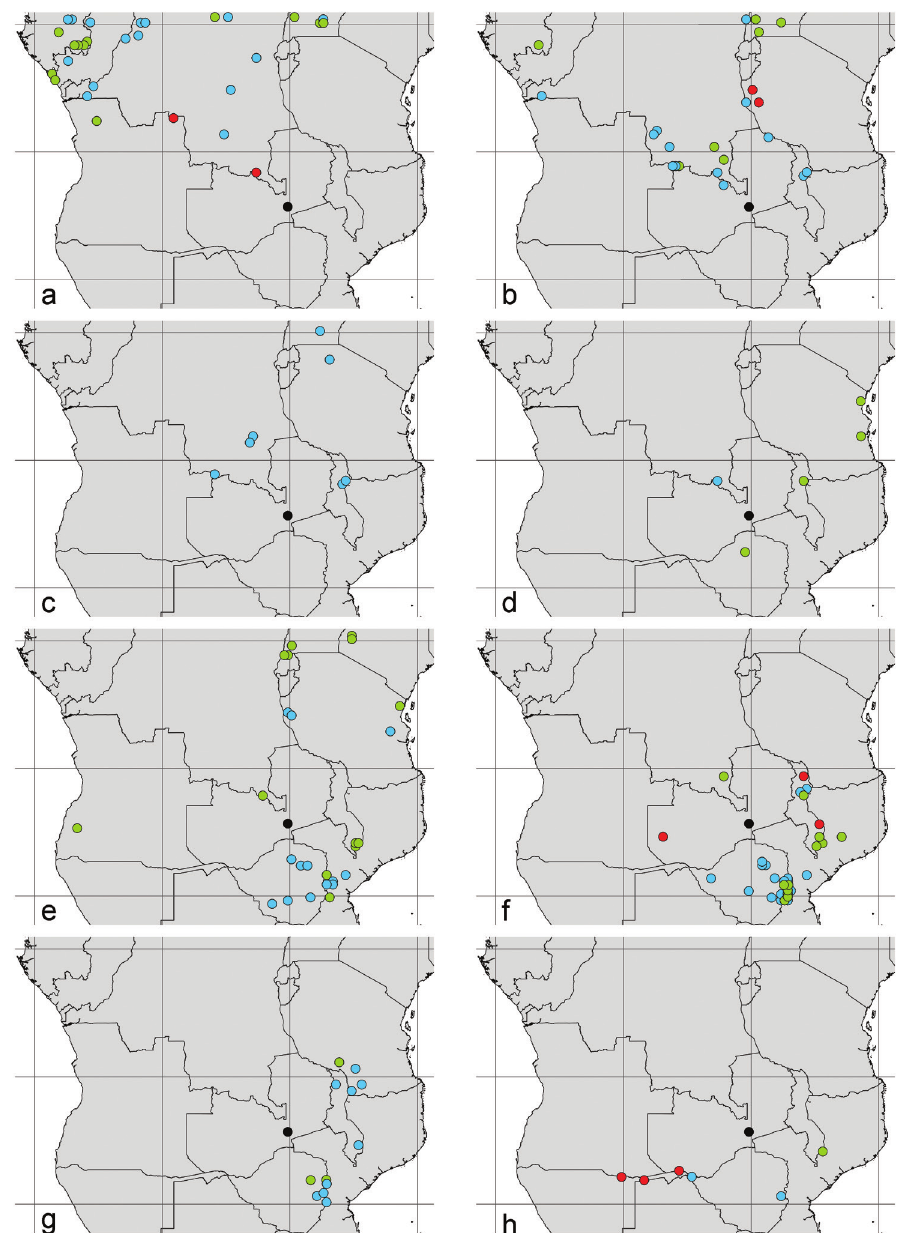
Figure 10. Distribution of selected dragonfly species in the southern Afrotropics (between the Equator and the southern border of Zimbabwe): a Heliaeschna fuliginosa b Gynacantha vesiculata c Heliaeschna trinervulata d Gynacantha immaculifrons e Notiothemis jonesi f Allocnemis marshalli g Notogomphus zernyi h Mastigogom- phus dissimilis . The black dot – the new locality. Other points – other data according to literature and Odonata Database of Africa (J. Kipping pers. comm., Clausnitzer et al. 2012) and recent unpublished data (B. Brink and H. Kageler pers. comm.), mostly drawn from the ADDO (African Dragonflies and Damselflies Online) web- site: blue – pre-1990 records; green – vetted since-1990 records; red – identification and/or locality